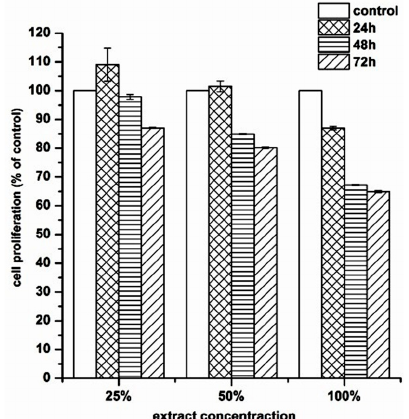
Figure 6. The effect of MPTL extracts on the in vitro growth of mouse embryonic fibroblast NIH 3T3 cells measured using MTT assay. Cell proliferation is represented as a percentage of control cell growth in cultures containing no MPTL extracts. Results are a mean ± SD of two separate experiments wherein each treatment condition was repeated in two wells. * p < 0.05; *** p < 0.001 vs. control.